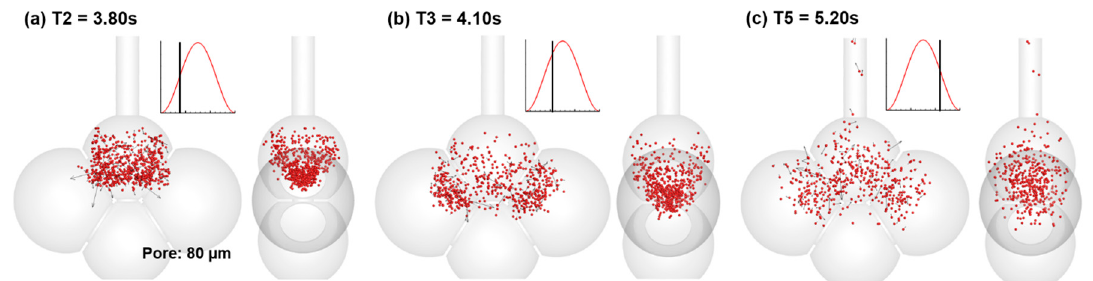
Figure 7. Snapshots of particle positions in the 80- µ m-pore alveolar model during the first cycle at different instants: ( a ) T2 = 3.80 s, ( b ) T3 = 4.20 s, and ( c ) T5 = 5.20 s. In comparison to the snapshots of